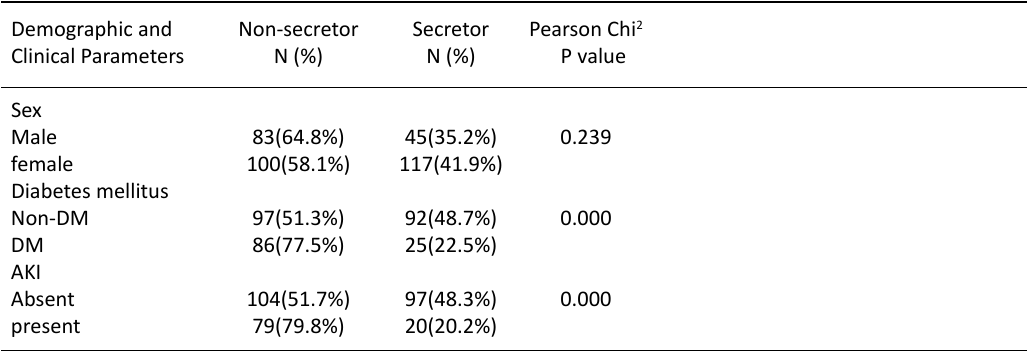
Table 5. Correlation of secretor status with sex, diabetic status and AKI in patients with UTI Demographic and Non-secretor Secretor Pearson Chi 2 Clinical Parameters N (%)